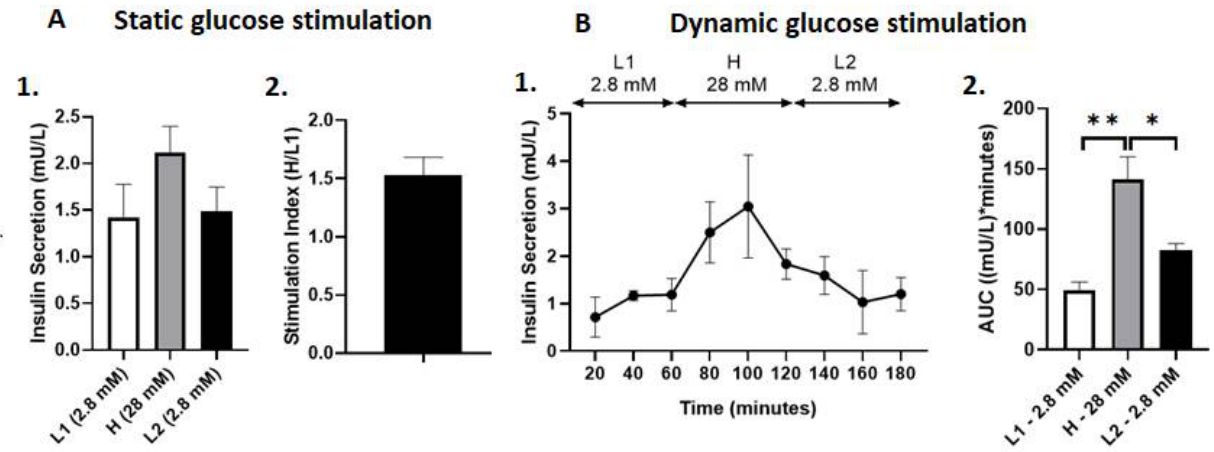
Figure 5. ( A ) Static glucose stimulated insulin secretion of PPIs after aerosolization into the lungs. (1) Insulin secretion (mU/L) in glucose media at varying concentrations. (2) Stimulation Index, calculated as the insulin secretion in H media over L1 media. Data are expressed as mean +/ − SEM. ( B ) Dynamic glucose stimulated insulin secretion of PPIs after aerosolization into the lungs. (1) Dynamic insulin secretion (mU/L) throughout 180 min of perfusion assay. (2) Total insulin secretion expressed as AUC. * p < 0.05, ** p < 0.01. Data are expressed as mean +/− SEM.